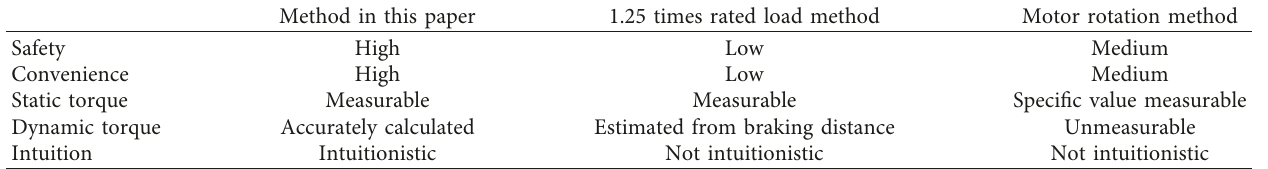
Table 8: Comparison of 3 test